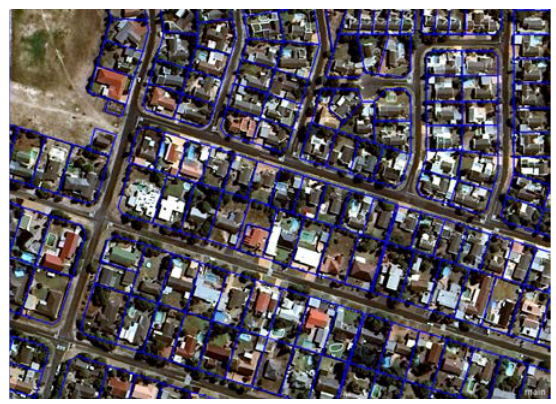
Figure 7: Segmentation based on cadastral parcels After the initial segmentation, a second segmentation was performed within the boundaries of the cadastral segments. These resulting smaller segments were then classified using the nearest neighbour approach. Samples were selected and the following features were used in the NN classification: mean values for red, green, blue and near infrared, brightness, maximum difference and NDVI.